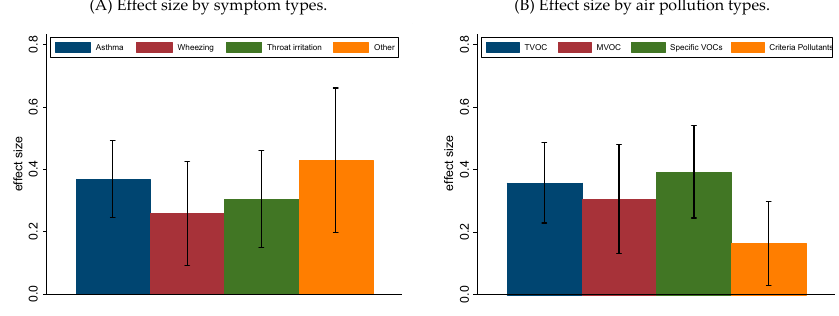
Figure 1. Study specific effect size of the association between volatile organic compound (VOC) exposure and four different health outcomes: development of asthma, wheezing, throat irritation and others (which included respiratory